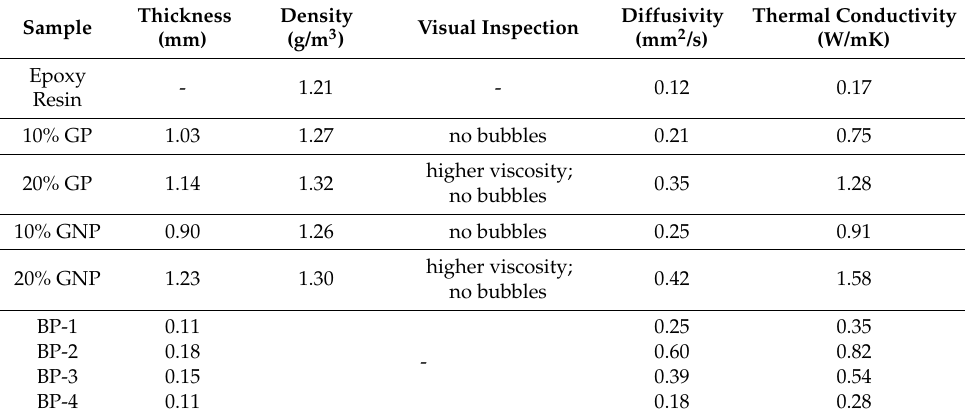
Table 13. Thermal diffusivity and conductivity values of graphite and CNT-based samples.